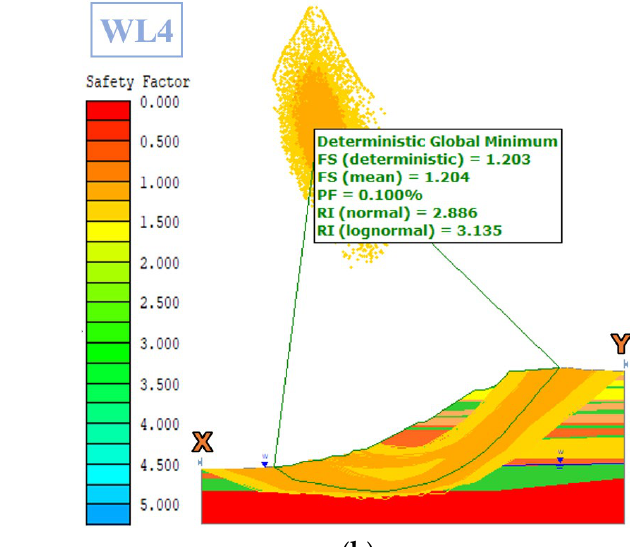
Figure 11. Bishop simplified sliding surfaces with safety factor less than 1.35 from Slide2 software. ( a ) Results for WL3 modeled water level, considering the minimum values of water levels measured in 2020; ( b ) Results for WL4 modeled water level, taking into account the maximum values of water levels measured in 2020.